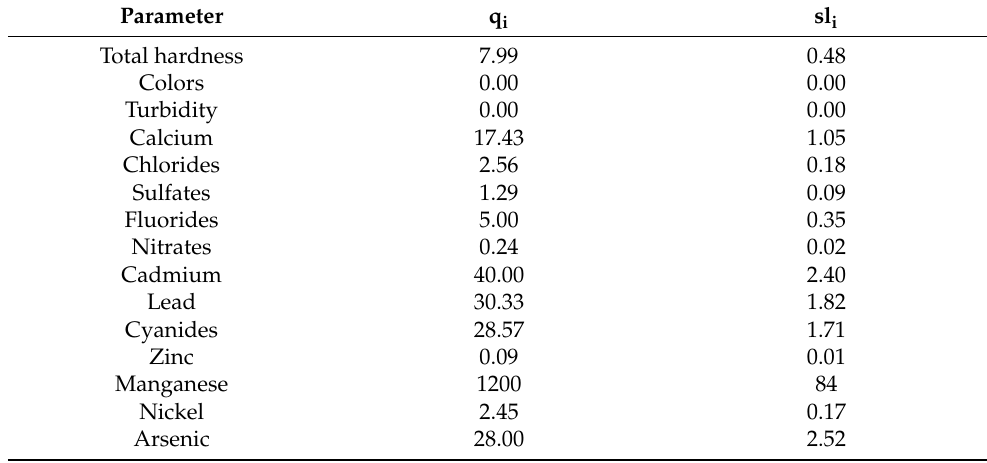
Table 10. Summary of the outcomes of the development of the water quality indices using the effluent treated with synthetic